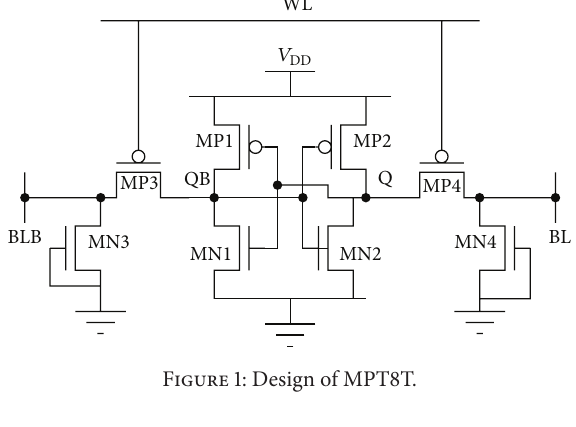
Figure 1: Design of MPT8T.